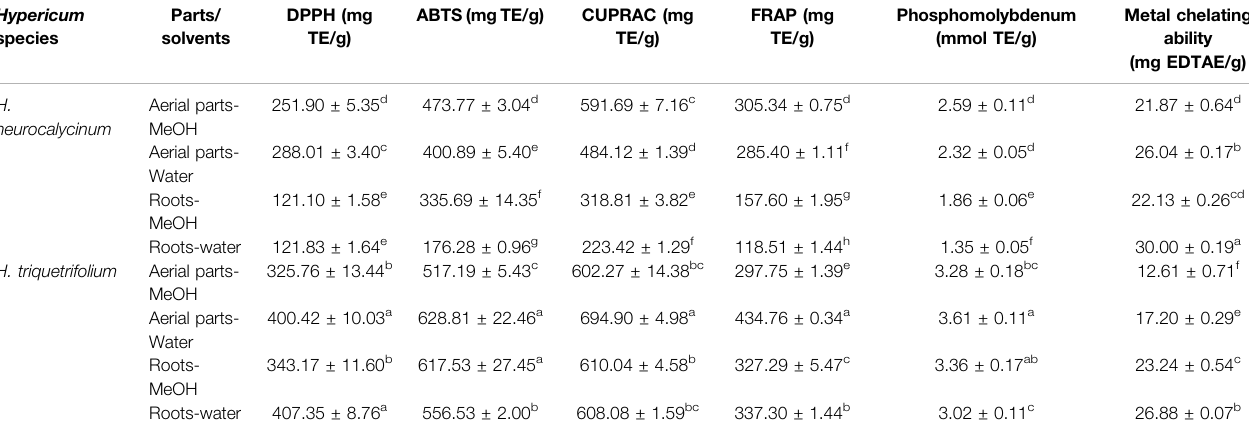
TABLE 3 | In vitro antioxidant properties of Hypericum triquetrifolium and Hypericum neurocalycinum extracts. Hypericum